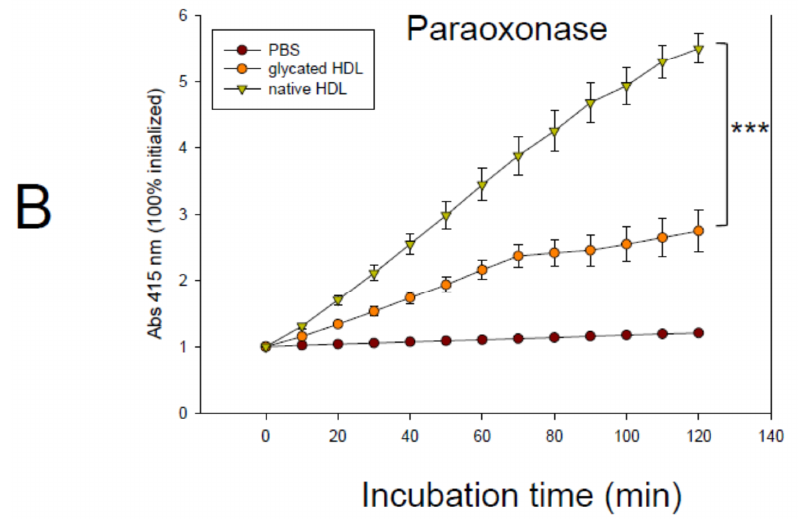
Figure 2. Observation of the HDL particle and antioxidant activity. ( A ) Negatively stained image of HDL from transmitted electron microscopy at a magnification of × 40,000. Scale bar (yellow) indicates 100 nm. ( B ) Changes in the activity of paraoxonase in HDL with or without glycation. The error bars indicate the SD from three independent experiments with duplicate samples. The molar extinction coefficient of p-nitrophenol was 17,000 M − 1 cm − 1 . ***, p < 0.001.